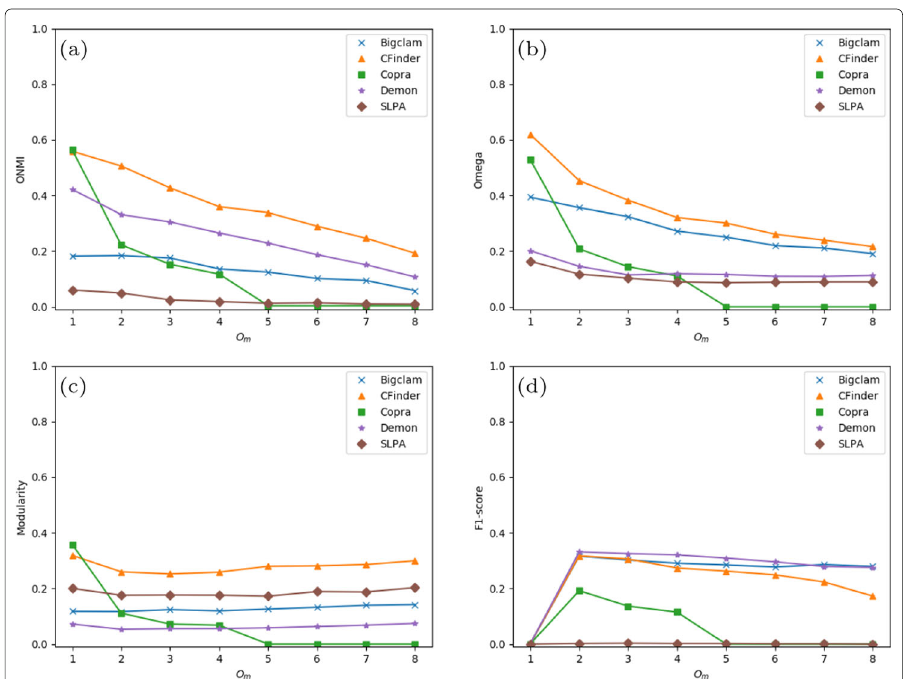
Fig. 2 Variation of the maximum number of memberships ( O m ) for LFR synthetic networks considering: a ONMI; b Omega; c Modularity and d